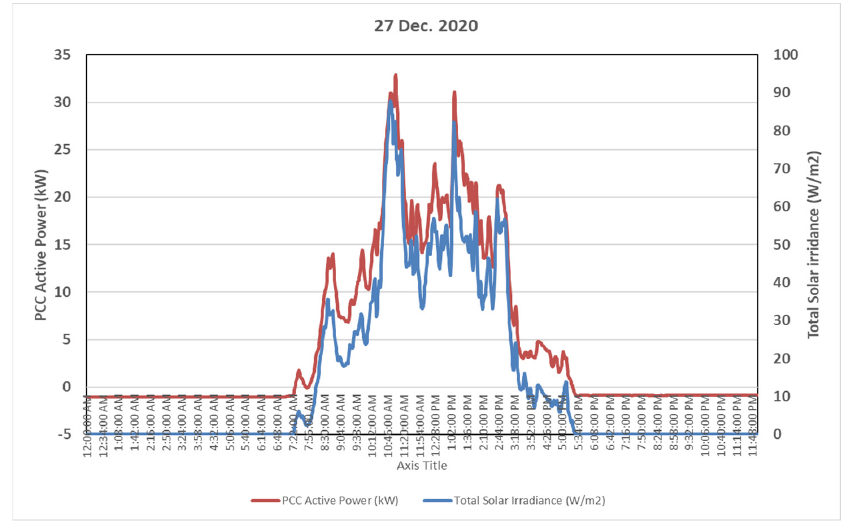
Figure 14. Power vs. irradiance on a very cloudy day.